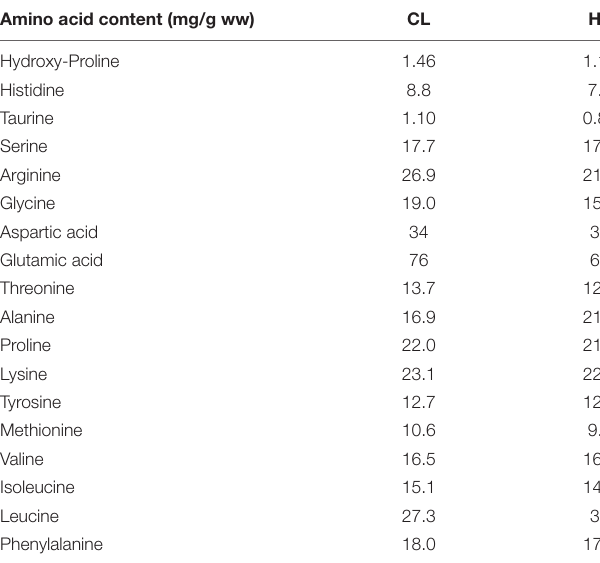
TABLE 2 | Amino acid content (mg/g wet weight) within the experimental diets with control leucine (CL; 27.3 g/kg) or high leucine (HL; 35 g/kg)